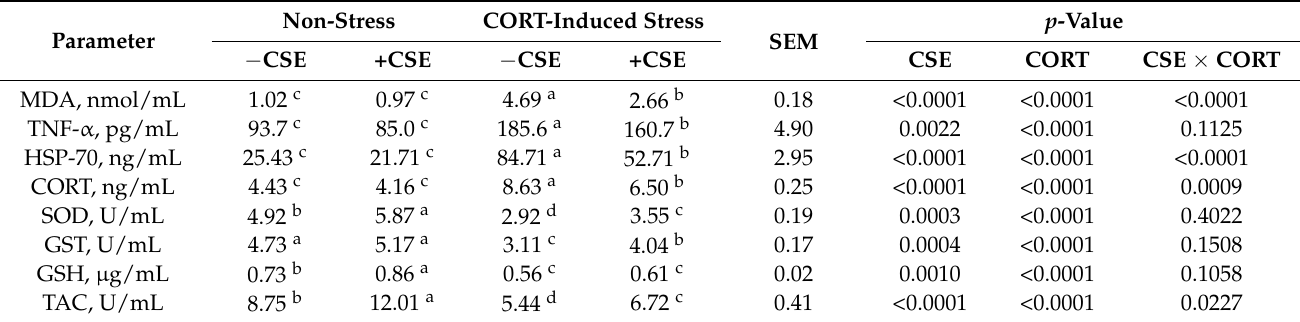
Table 4. Stress markers and redox parameters of broiler chickens fed corn silk extract (CSE) and subjected to corticosterone-induced oxidative stress (CORT).